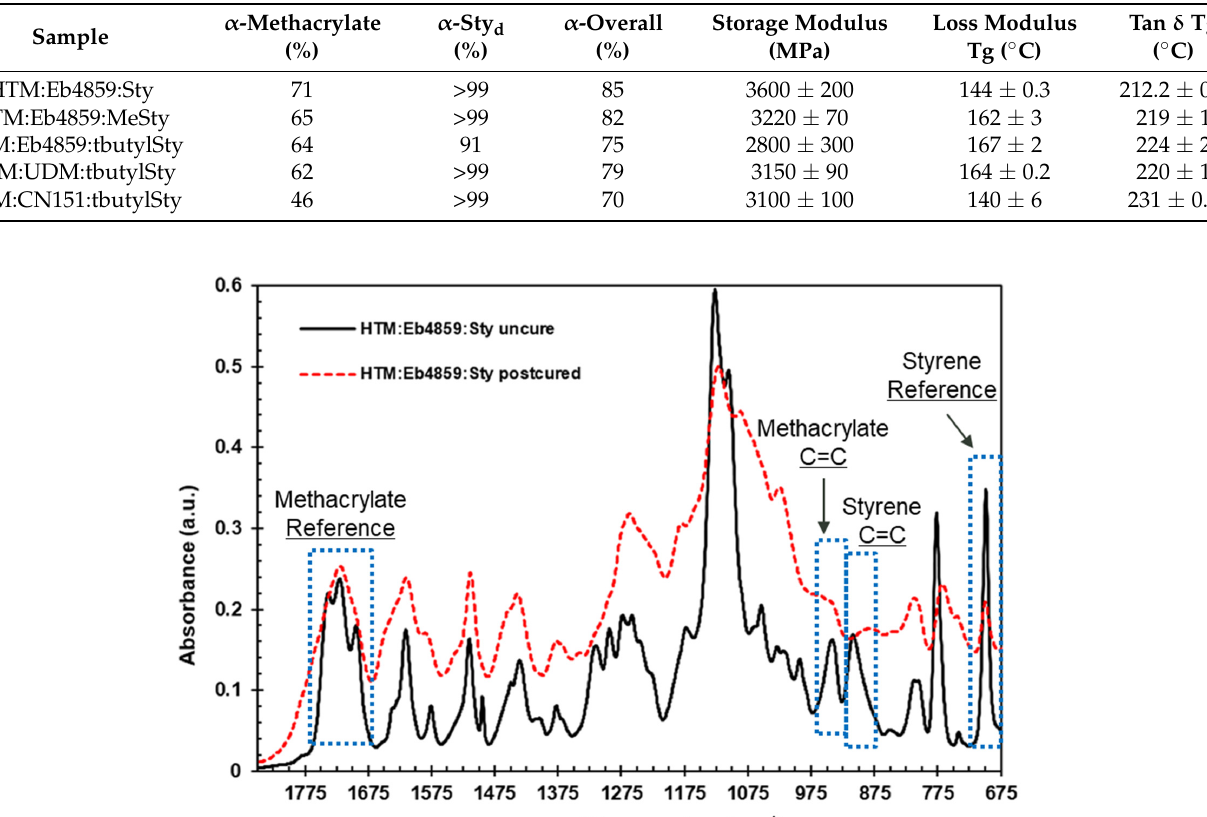
Table 6. Extent of cure and thermomechanical properties of 3D printed HTM ternary thermosets.